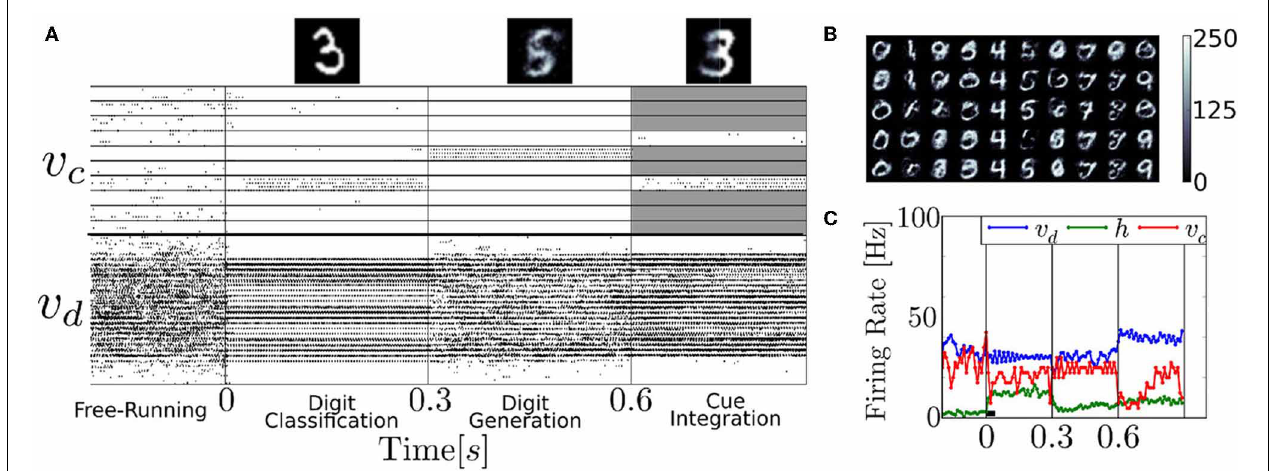
FIGURE 9 | The recurrent structure of the network allows it to classify, reconstruct and infer from partial evidence. (A) Raster plot of an experiment illustrating these features. Before time 0 s , the neural RBM runs freely, with no input. Due to the stochasticity in the network, the activity wanders from attractor to attractor. At time 0 s , the digit 3 is presented (i.e., layer υ d is driven by d ), activating the correct class label in υ c ; At time t = 0 . 3s, the class neurons associated to 5 are clamped to high activity and the rest of the class label neurons are strongly inhibited, driving the network to reconstruct its version of the digit in layer υ d ; At time t = 0 . 6s, the